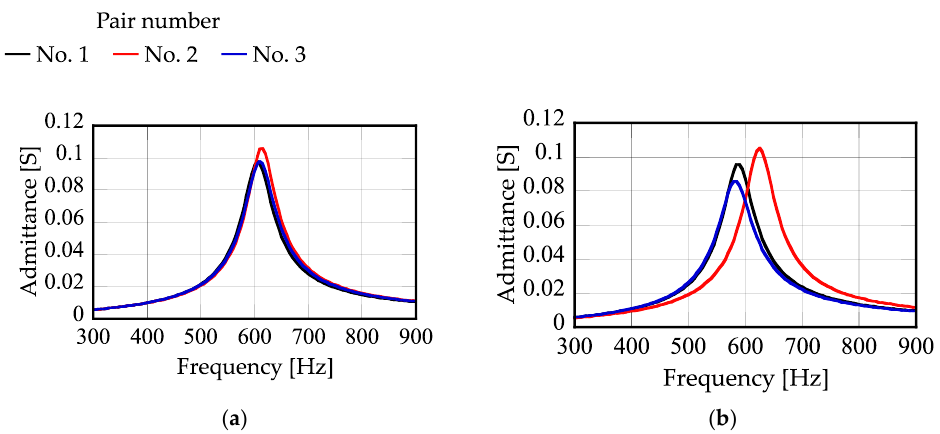
Figure 16. Frequency characteristics of combined electromagnets and capacitors. Dashed line rep- resents the driving frequency (800 Hz). ( a ) Primary electromagnet. ( b ) Secondary electromagnet.